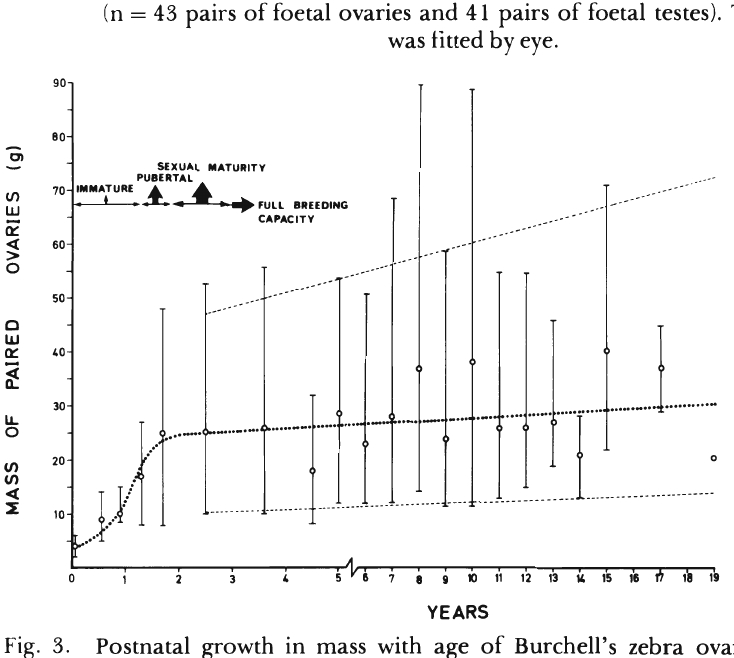
Fig. 3. Postnatal growth in mass with age of Burchell's zebra ovaries. The sample includes ovaries from 257 mares between birth and 19 years of age. The vertical lines indicate total variation within each age class and the two almost horizontal broken lines, the average maximum and average minimum mass for paired ovaries from mature mares. The broken lines thus illustrate average mass of the inactive ovary (lower line) and average mass of the ovary when at maximum activity (upper line). Average data on puberty and sexual maturity are also illustrated. The curve was fitted by